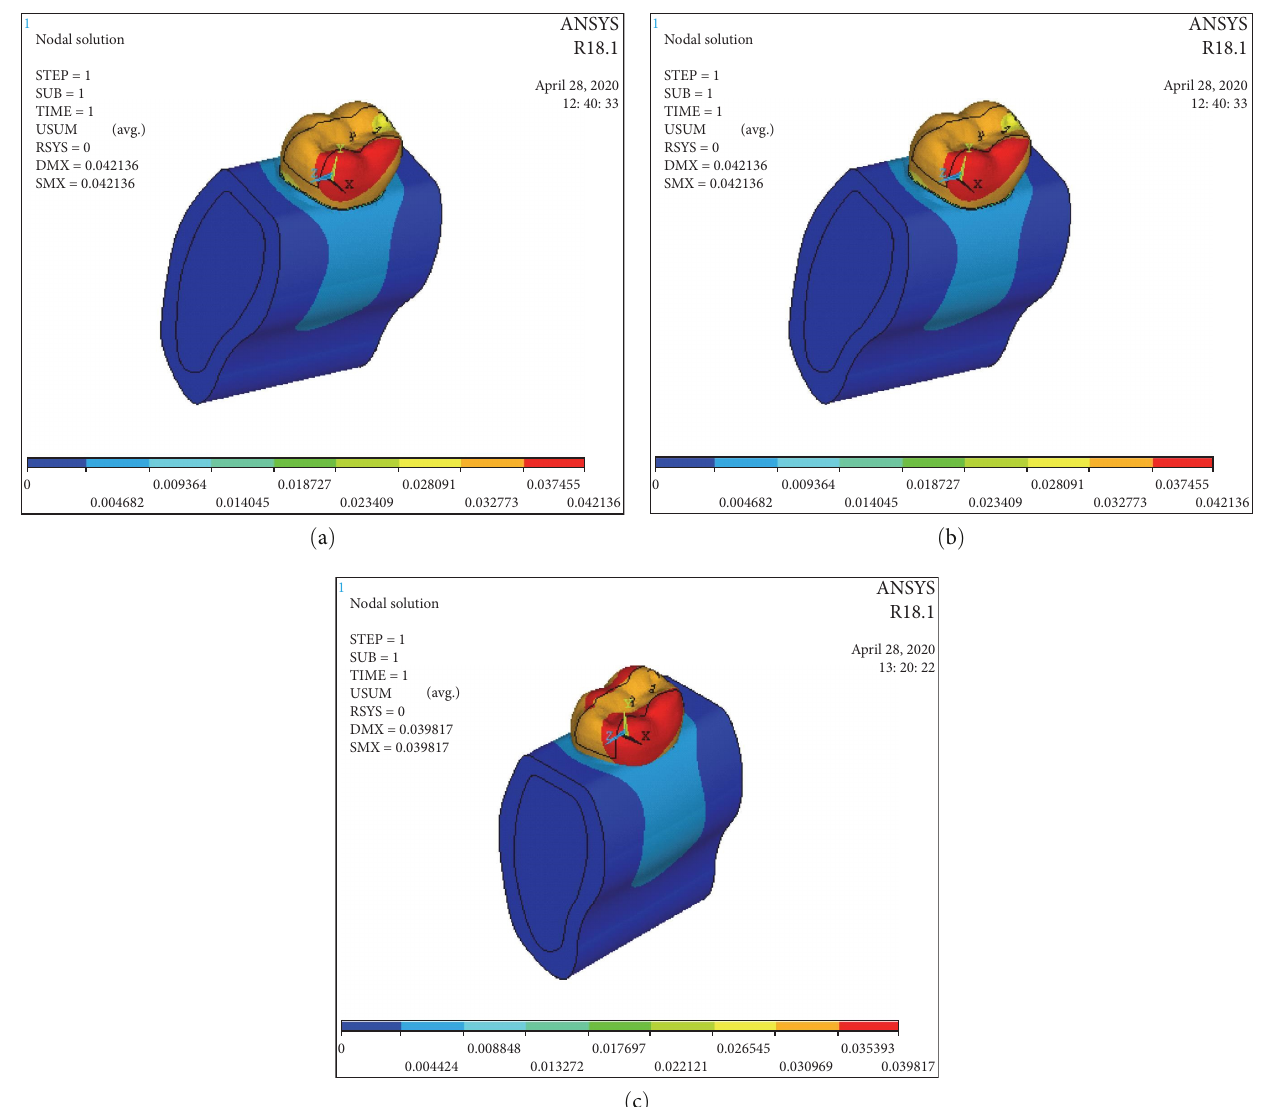
F IGURE 7: (a) The stress analysis of the 1 mm horizontal postrestored with posterior composite shows stress concentration on the whole buccal surface, including the functional cusps; (b) the stress analysis of the 1.5mm horizontal postrestored with posterior composite shows stress concentration on the whole buccal surface, including the functional cusps. The magnitude of stresses is more than that of 1 mm; (c) the stress analysis of the 2 mm horizontal postrestored with posterior composite shows stress concentration on the whole buccal surface, including the functional cusps. The lingual cusps also show an increased concentration of stress. The magnitude of stresses is less than that of 1 or 1.5mm horizontal